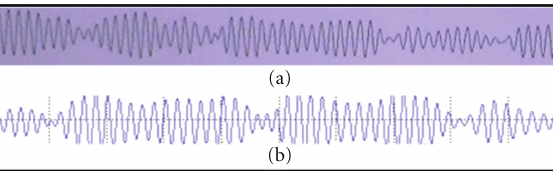
Figure 12: Wave measurement for eye-closing.